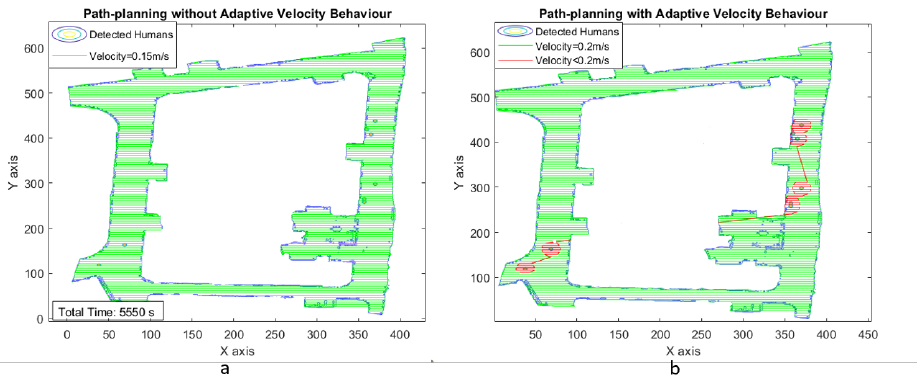
Figure 15. Zig-zag-based area coverage path generated for scenaio III.